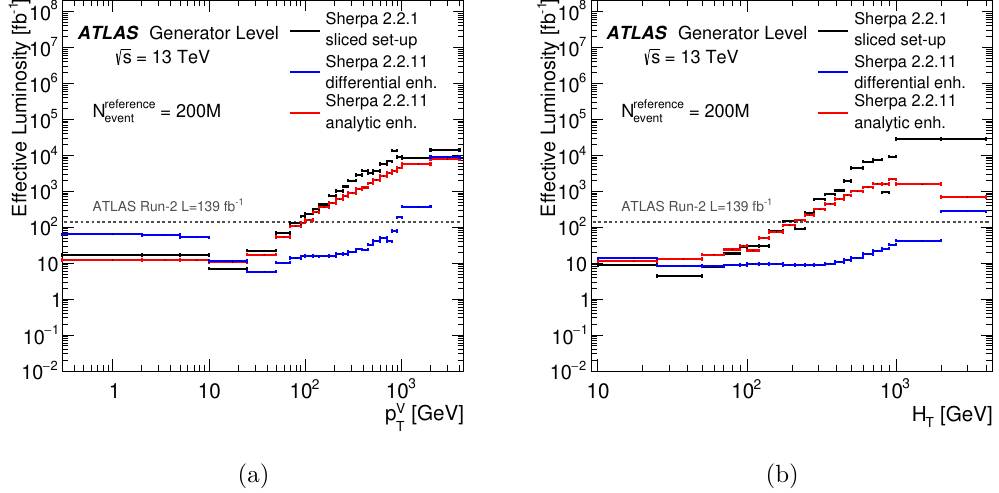
Figure 15 . Differential distributions of the effective luminosity of each of the Sherpa configurations as a function of (a) p V of 200 M events. The truncated lowest bin includes events with p V